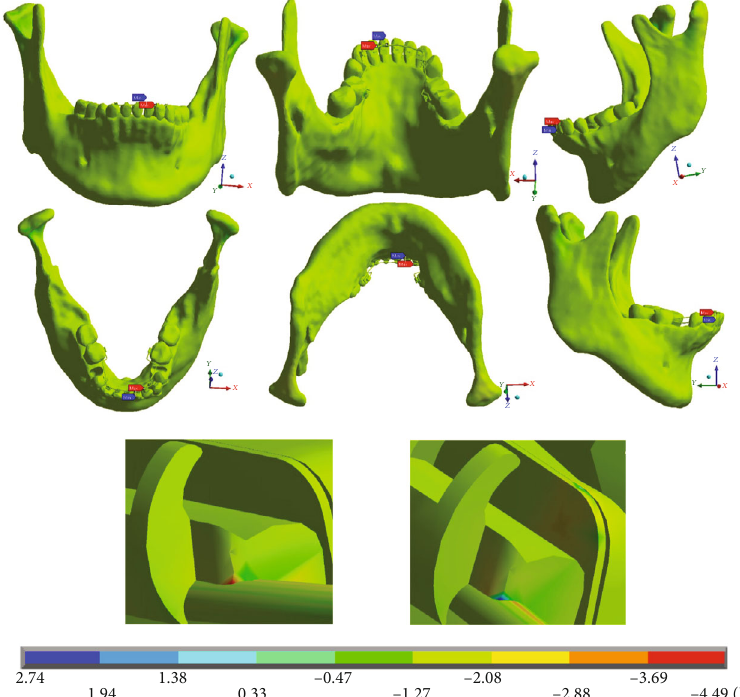
Figure 15: Normal stresses in the Z complete system (mandibular bone, dental organs, brackets, and wires). The red marker indicates the maximum stresses, and the blue marker indicates the minor stresses.